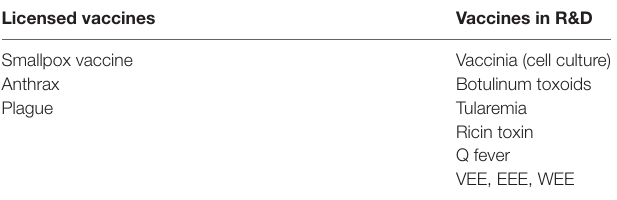
TAbLe 2 | Vaccines for bioterrorism. Licensed